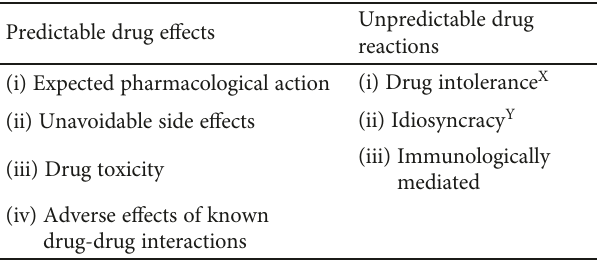
Table 1: Predictable and unpredictable reactions to systemic medications: general considerations